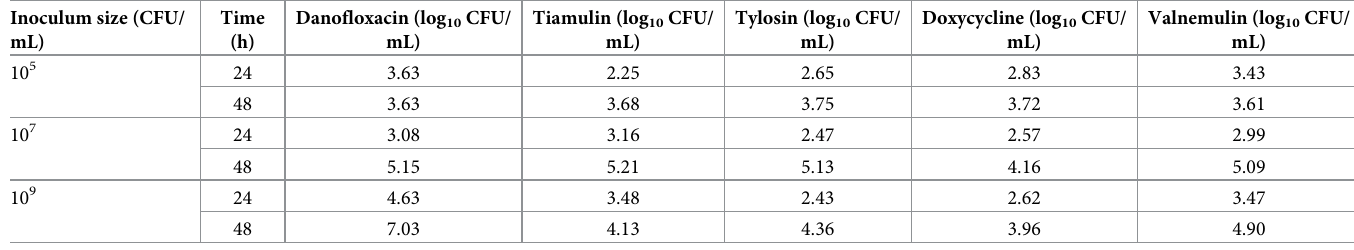
Table 3. Reduction in M . hyopneumoniae growth for three different inoculum sizes based on measured MPC concentrations. Inoculum size (CFU/ mL)